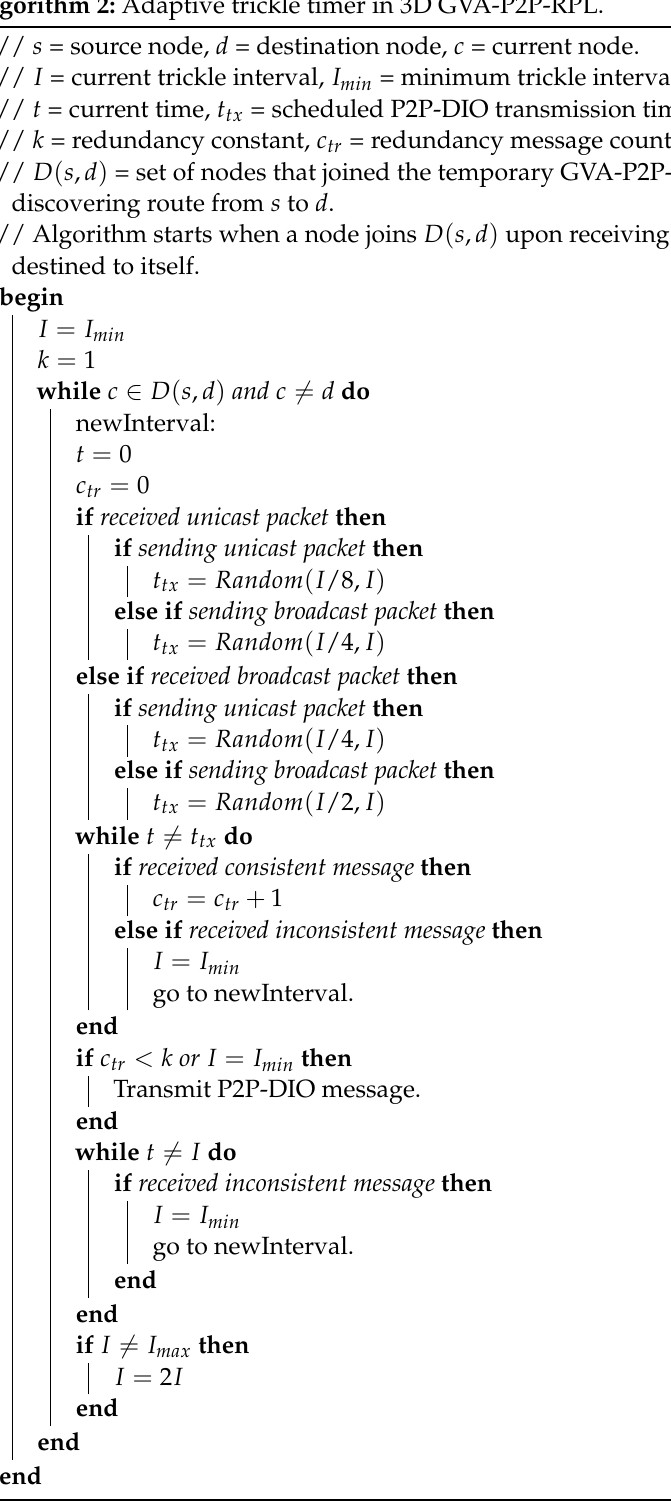
Algorithm 2: Adaptive trickle timer in 3D